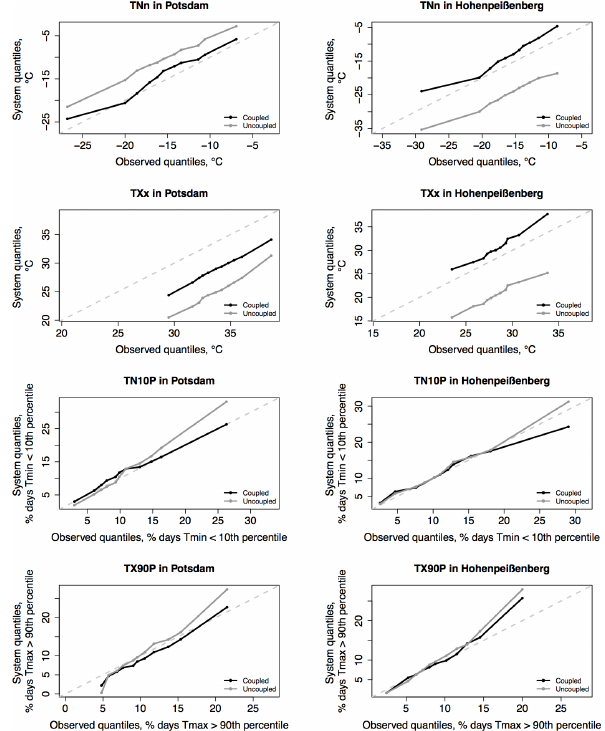
Figure 15. Quantile–quantile plots of the extreme indices shown in Fig. 14. The diagonal represents the perfect